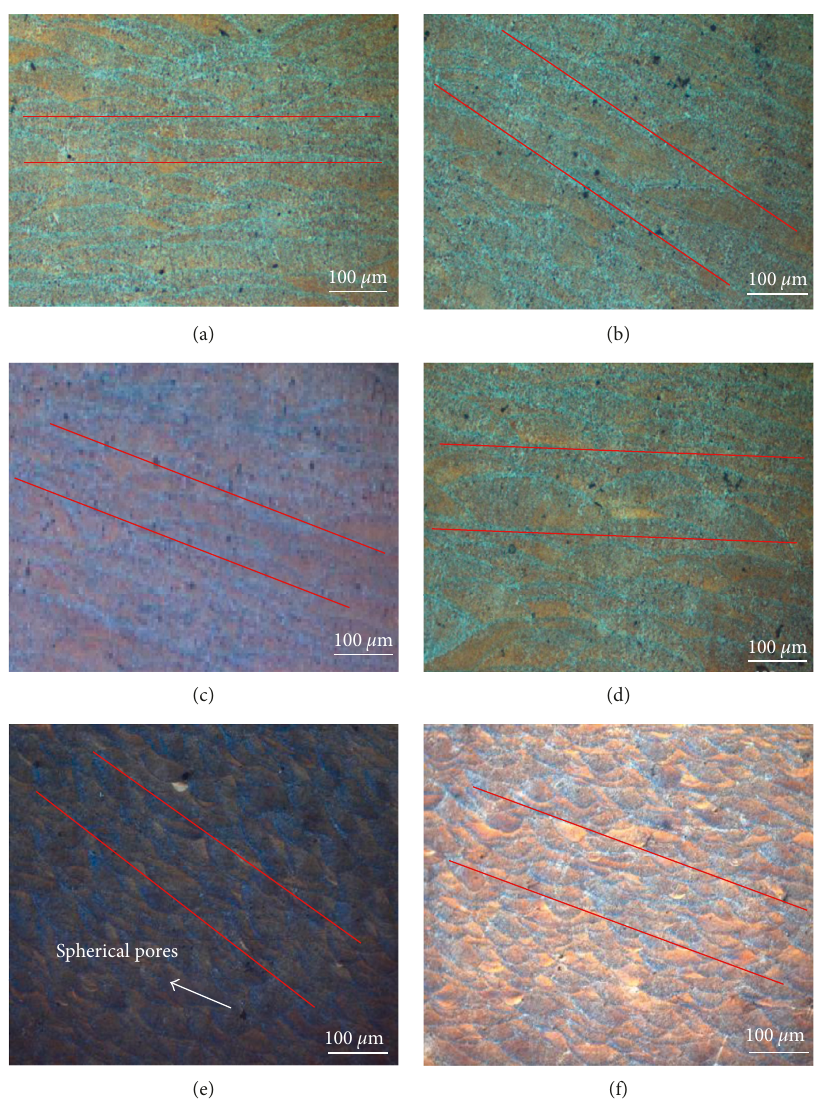
Figure 11: The typical etched morphology of cross section surface of SLM-processed AlSi10Mg samples at (a) chessboard scanning, preheating temperature of 80 ° C; (b) chessboard scanning, preheating temperature of 120 ° C; (c) chessboard scanning, preheating tem- perature of 160 ° C; (d) uniformity scanning, preheating temperature of 80 ° C; (e) uniformity scanning, preheating temperature of 120 ° C; and (f) uniformity scanning, preheating temperature of 160 °